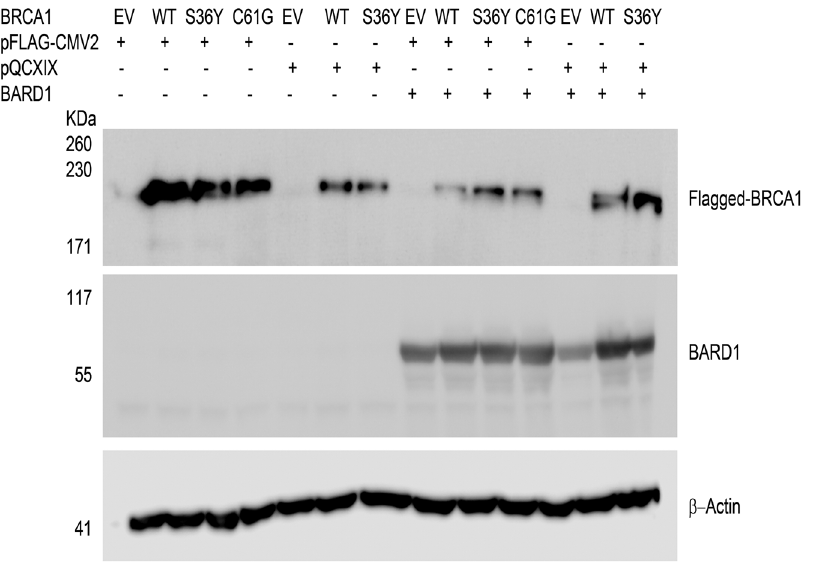
Figure 1. Expression of full-length, epitope-tagged BRCA1 in HEK293T cells. Protein expression analysis of wild type BRCA1, p.Ser36Tyr (S36Y) VUS and of the known pathogenic p.Cys61Gly (C61G) variant following transient transfection in HEK293T cells was confirmed with the anti- DYKDDDDK tag antibody that recognizes ectopically expressed BRCA1. Immunoblot analysis detected a 220 KDa band which corresponds to full-length BRCA1 protein. Both p.Ser36Tyr and p.Cys61Gly variants demonstrated reduced protein expression compared to wild type BRCA1. Co-transfection with wild type BRCA1 andBARD1 inducedan increase in BARD1 protein expression (Supp Fig.1). EV corresponds to empty vectorandWT to wild type protein. b -actin served as loading control. The results are representative of between 3 and 5 experiments.